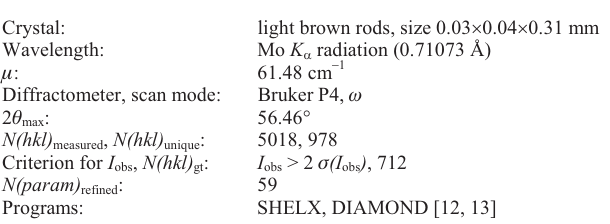
Atomic coordinates and displacement parameters (in Å 2 )